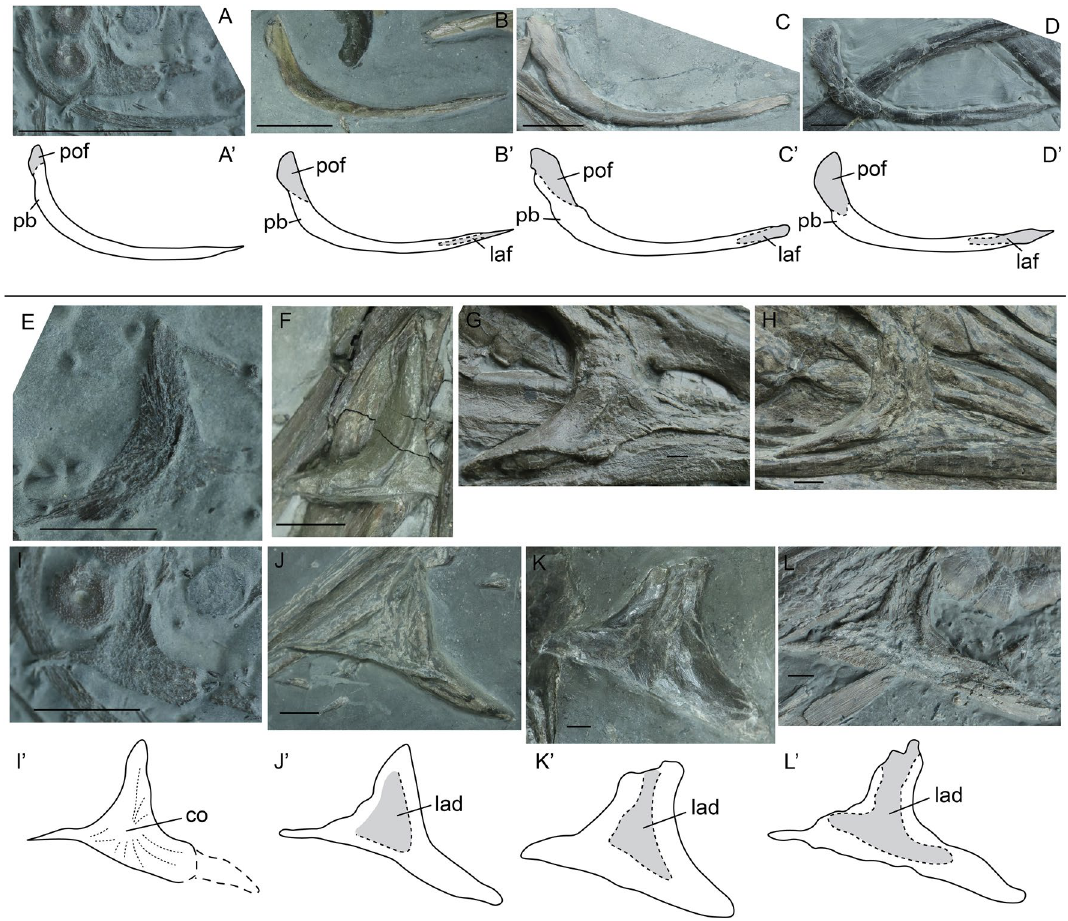
Figure 2. Jugals in lateral view ( A – D ) and lacrimals in lateral view ( E – H ) and medial view ( I – L ) of selected specimens of Stenopterygius. Interpretative drawings denoted by an apostrophe with their corresponding letter. ( A ) stage 3 embryo S. quadriscissus SMNS 80234; ( B ) postnatal 1 SMNS 81806 Stenopterygius sp . ( C ) postnatal 2 S. quadriscissus SMNS 81958; ( D ) sexually mature S. quadriscissus SMNS 80234 ( E ) stage 3 embryo S. quadriscissus SMNS 80234; ( F ) postnatal 1 S. quadriscissus SMNS 51139; ( G ) sexually mature S. triscissus SMNS 96899; ( H ) sexually mature S. quadriscissus SMNS 51948 ( I ) stage 3 embryo S. quadriscissus SMNS 80234; ( J ) postnatal 2 S. quadriscissus SMNS 51551; ( K ) sexually mature S. quadriscissus SMNS 50376; ( L ) sexually mature S. quadriscissus SMNS 81961. co centre of ossification, lad lacrimal medial depression, laf lacrimal facet, pb posterior bulge, pof postorbital facet. Scale bar: ( A–L ) = 20 Postorbital. The postorbital articulates in scarf- or step joints with the jugal, quadratojugal, squamosal and postfrontal. The postorbital is well ossified in embryonic stage 1 (Fig. 1). The circumorbital area is present in all observed ontogenetic stages, but is most prominent in the later stages. The shape of the postorbital changes over ontogeny from straighter to slightly more curved, with the squamosal and postfrontal facets shifting dorsally towards its dorsal-most point. The ventral portion of the postorbital, containing the jugal and quadratojugal facets, broadens antero-posteriorly over ontogeny (Supplemental Fig. 6A–D).